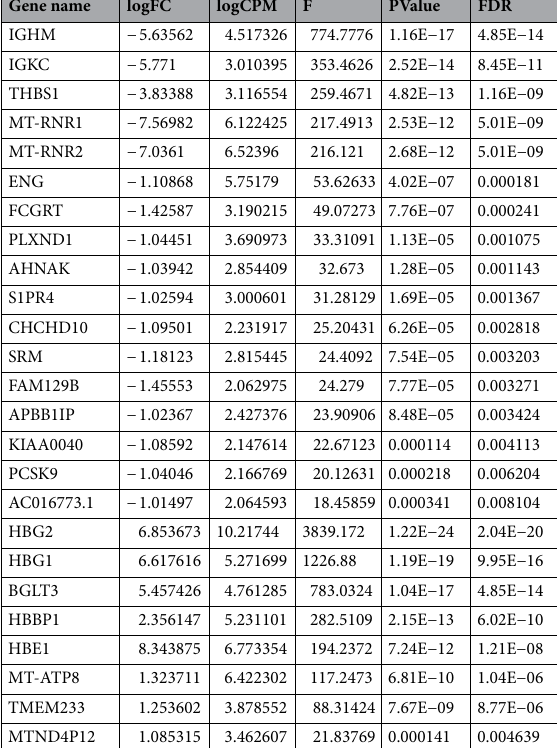
Table 1. Up and down regulated genes in HbF/HbA expressing cells versus HbA only expressing